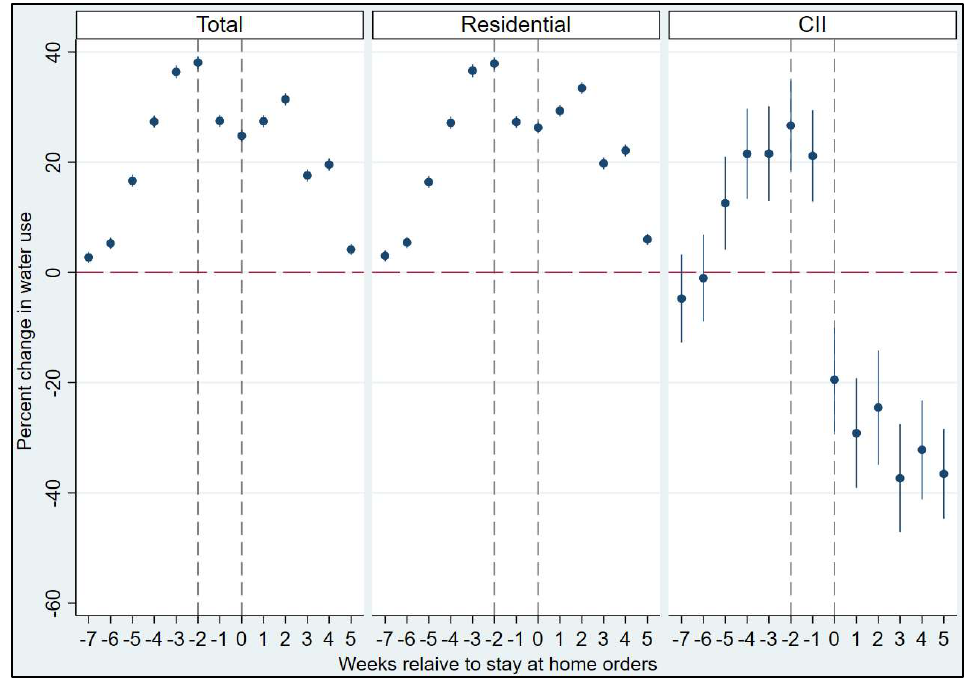
Figure 2. Weekly percent change in water use before and after the stay-at-home orders in Utility A (Northern California) for residential and CII sectors. Notes: First dashed line indicates the week of emergency orders, and the second dashed line indicates the week of stay-at-home orders. Week-7 is from February 12 to February 18.